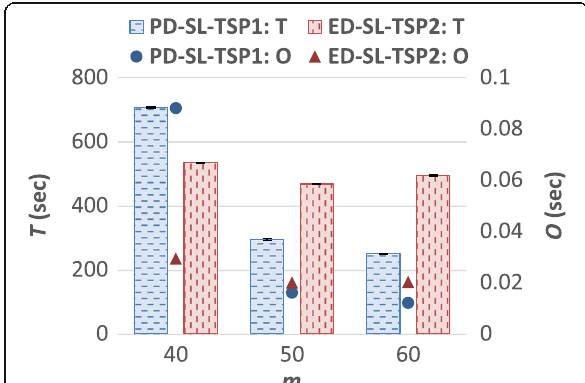
Fig. 13 Effect of m on T and O when using the CyberShake